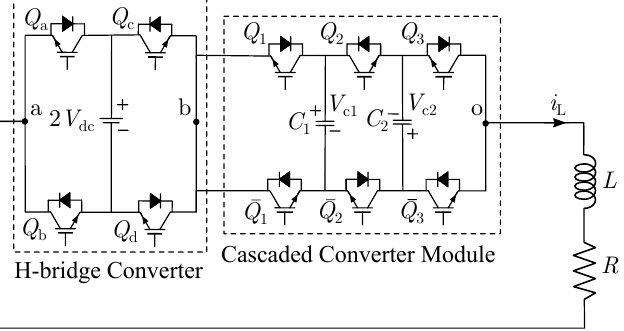
Figure 3. Seven-level inverter topology.